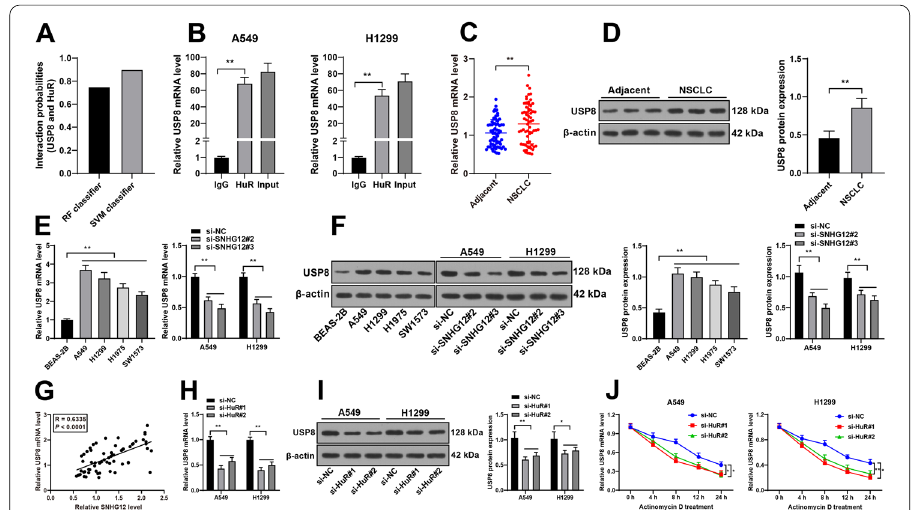
Fig. 5 lncRNA SNHG12 bound to HuR to increase mRNA stability and expression of USP8. A Probability of HuR binding to USP8 was predicted via the RPISeq database; B the binding relationship between USP8 and HuR was analyzed using RIP assay; C – F USP8 expression in NSCLC tissues and cells was measured via RT-qPCR and western blotting; G correlation between lncRNA SNHG12 and USP8 was analyzed via Pearson correlation analysis; H , I USP8 expression in NSCLC cells was measured via RT-qPCR and western blotting; J half-life period of USP8 mRNA in NSCLC cells was assessed via RT-qPCR. N 65, cell experiments were performed = three times, * P < 0.05, ** P < 0.01. Data in A , B , D – F , and H – J are represented as mean standard deviation. ± Pairwise comparisons in C and D were analyzed using t -test; multigroup comparisons in B , E , and F were analyzed using one-way ANOVA, and in E , F , and H – J were analyzed using two-way ANOVA, followed by Tukey’s multiple comparison test